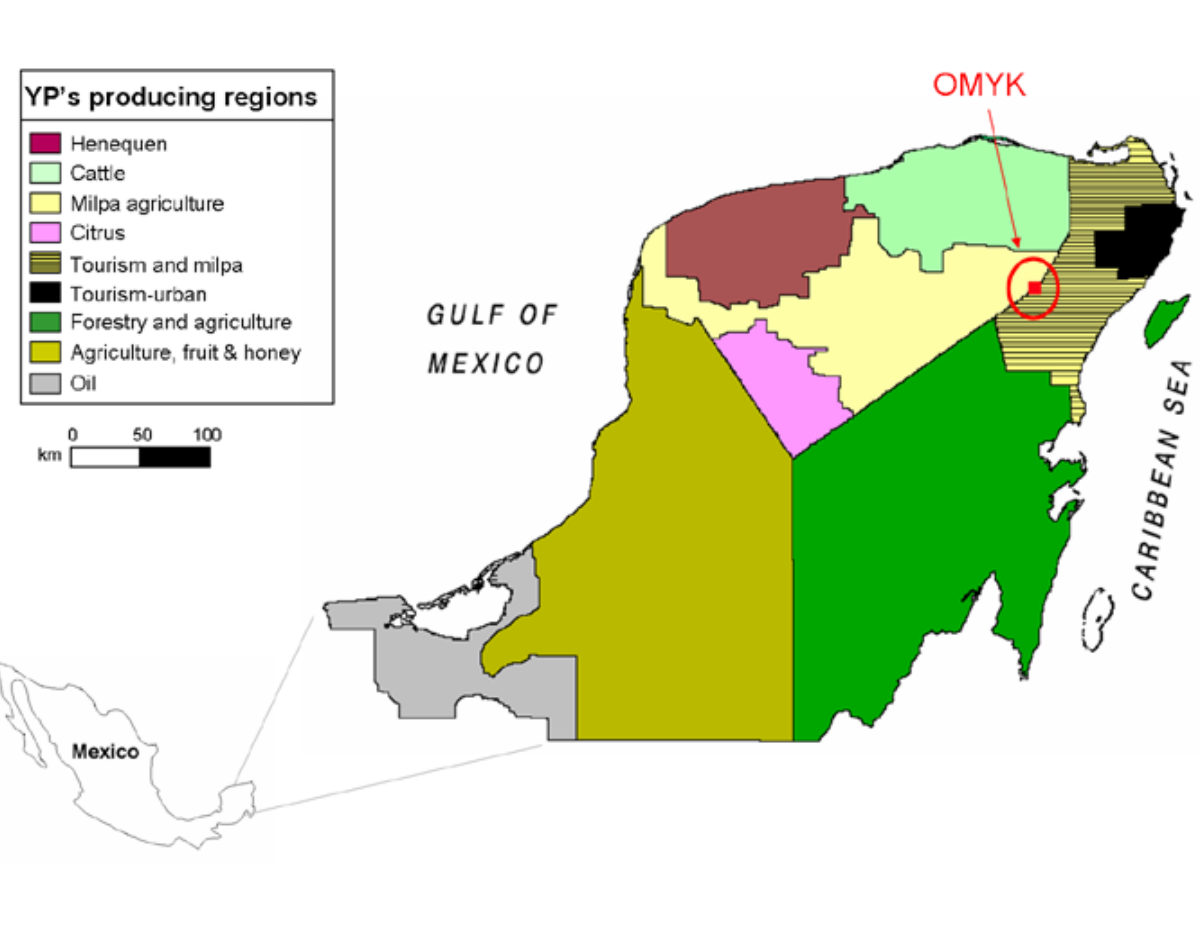
Fig. 1. Productive regions of the Yucatan Peninsula and study site location. (Source: modified from Batllori et al.